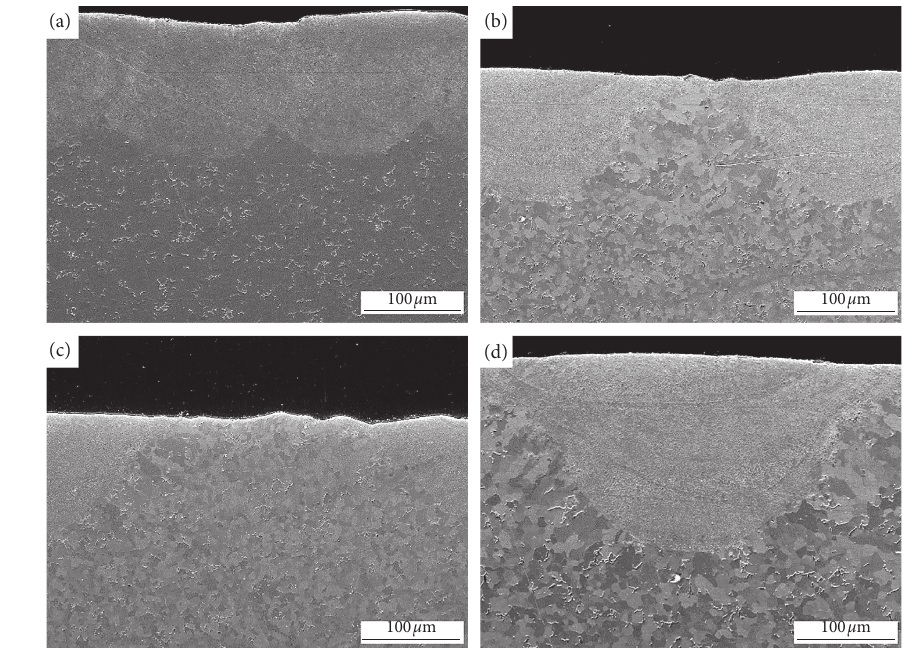
Figure 6: Sectional view of laser-treated area. (a) Case B. (b) Case C. (c) Case D. (d) Shape of a separate laser